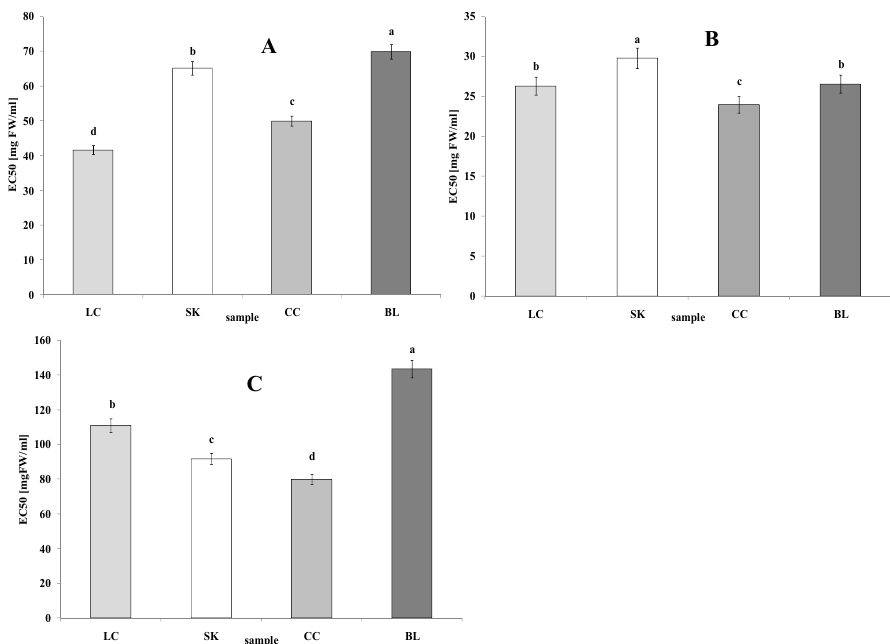
Figure 4. ABTS free radicals scavenging ability. ( A ) Hydroxyl radicals scavenging ability, ( B ) and chelating power ( C ) of extracts from red chard (LC), white beetroot (SK), red beetroot leaves (CC), and white chard (BL). Results are presented as the mean ± SD; the values designated by the different small letters (a, b, c, d) are significantly different ( α = 0.05).